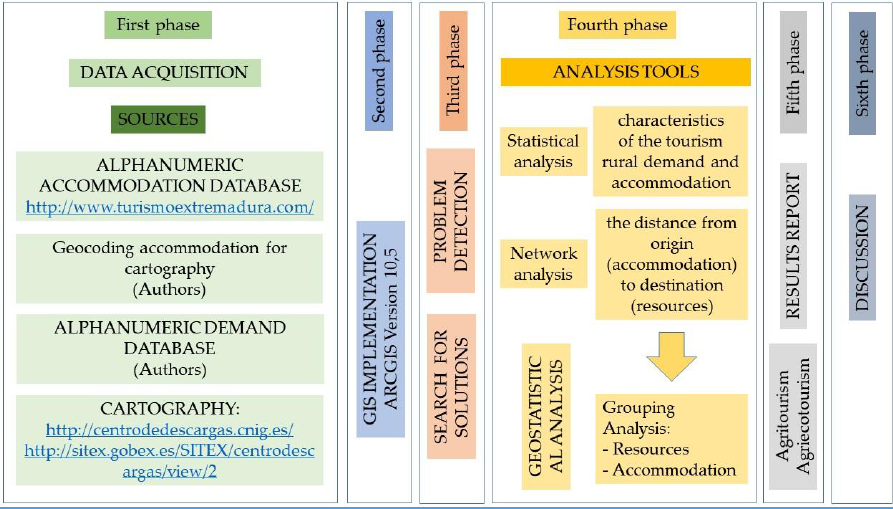
Figure 2. Methodological scheme.